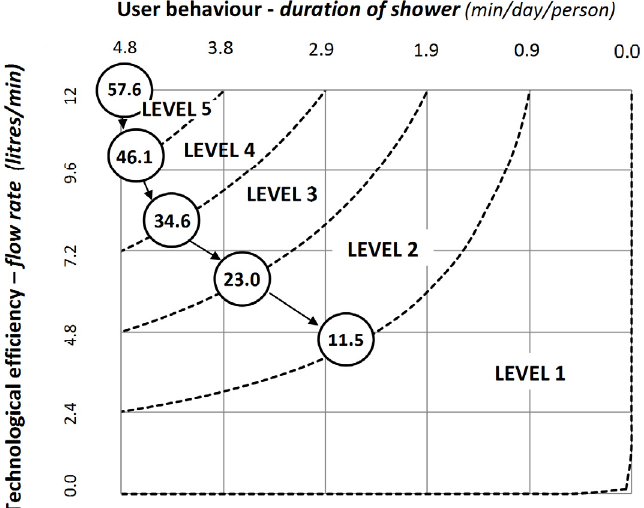
Figure 1. “Futures framework” analysis for showering (partial